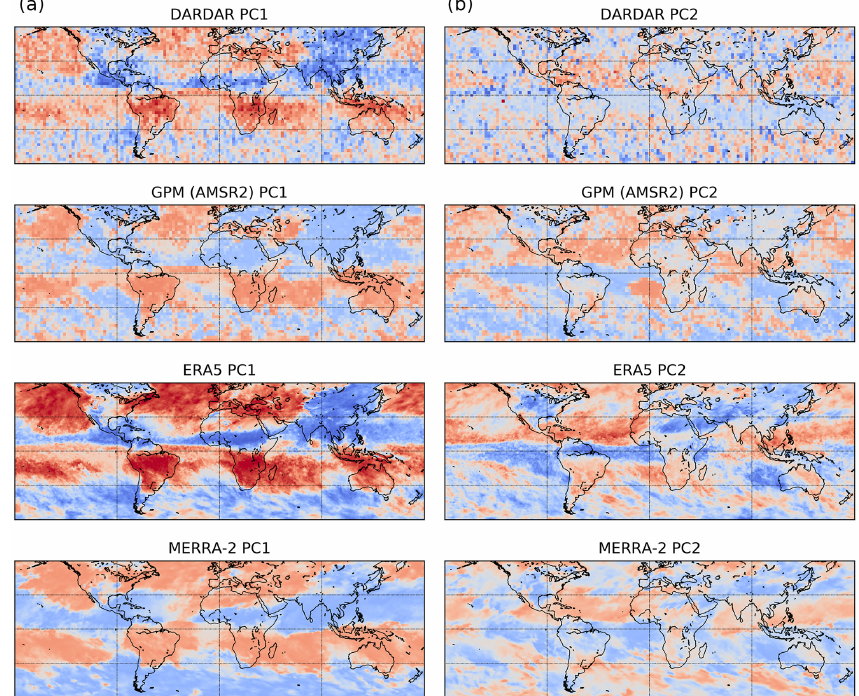
Figure 7. First (a) and second (b) principal components of IWP interseasonal variability, with seasons defined as DJF, MAM, JJA, and SON. The colour scale is nominal, linear, dimensionless, of arbitrary sign, and consistent between data sets. The time period comprises